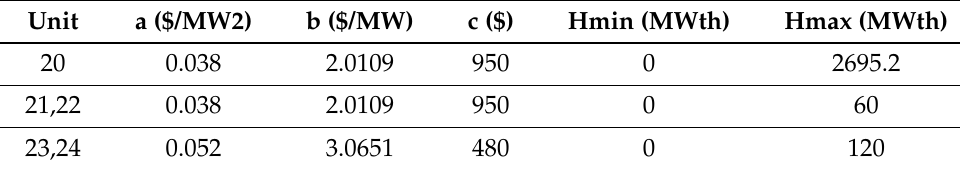
Table A12. Heat energy generator unit data for Case Study 4.